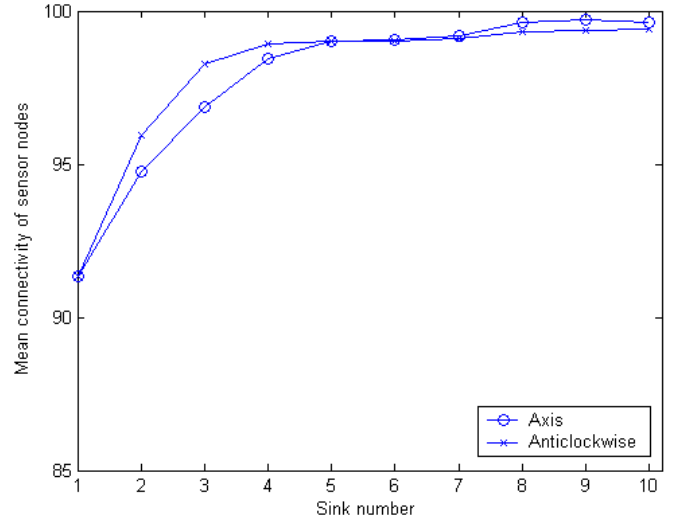
BCP (mean of 1,000 rounds).